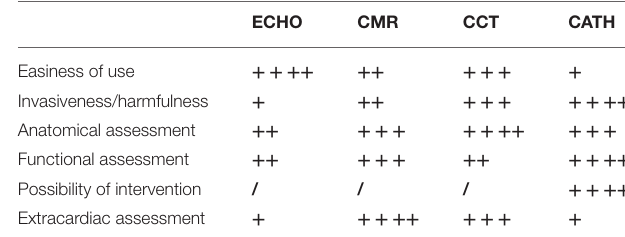
TABLE 1 | Schematic summary of main strenghts and weaknesses of each imaging